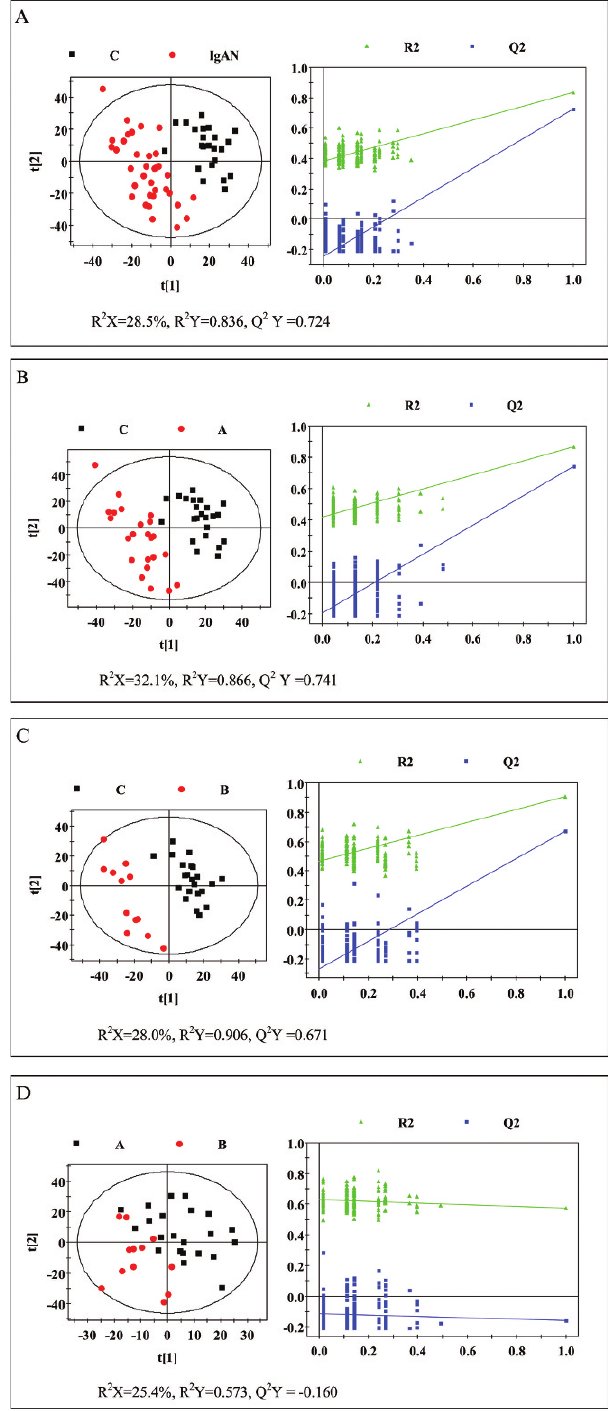
Figure 3 - Cross-validation of partial least squares-discriminant analysis (PLS-DA) models obtained from 200 permutation tests. PLS-DA score plots showing the separation between (a) controls and IgAN patients, (b) controls and IgAN-A patients, (c) controls and IgAN-B patients, and (d) IgAN-A and IgAN-B